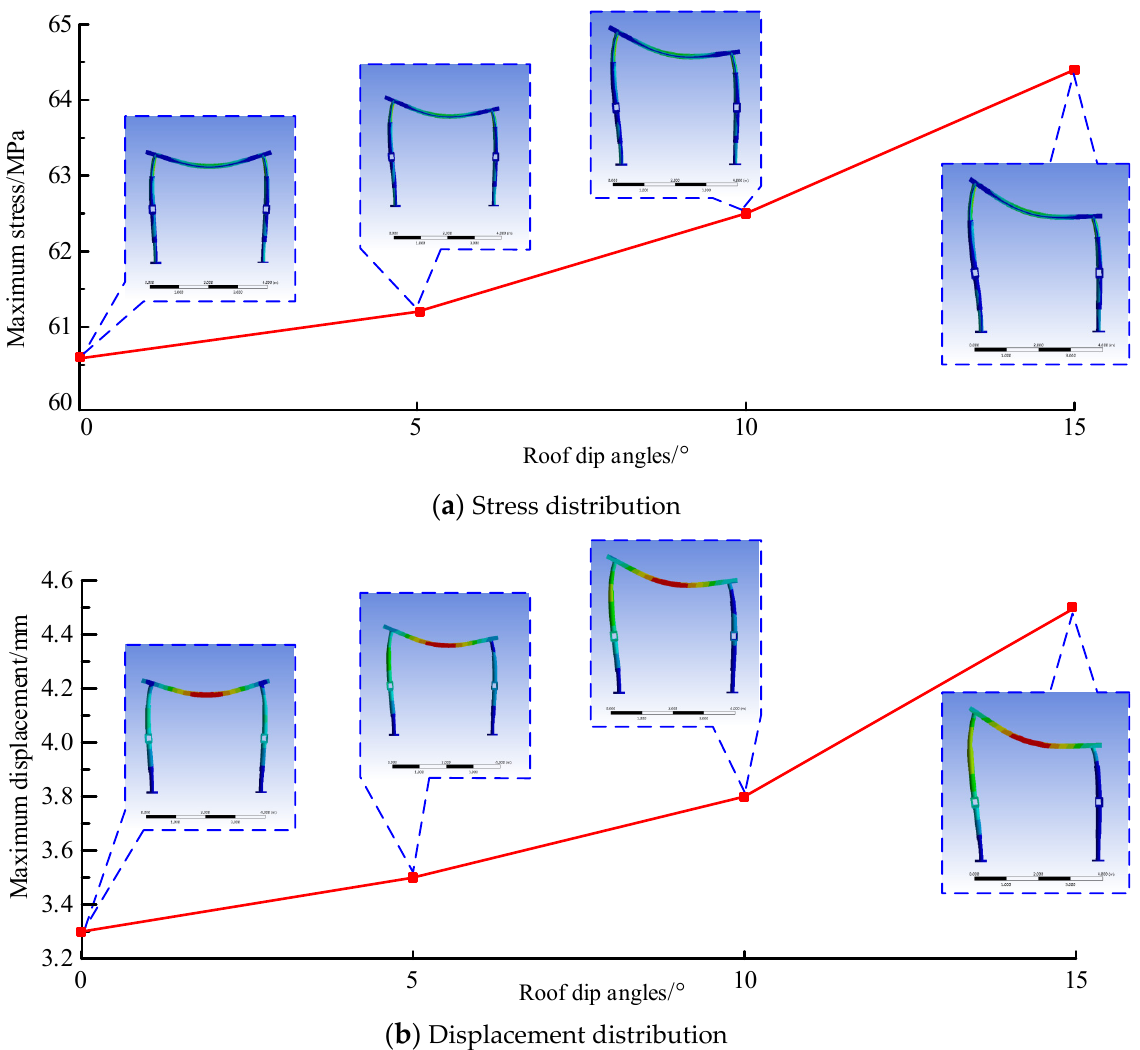
Figure 7. ( a ) Stress and ( b ) displacement distributions of the advance support under different roof-dip angles.